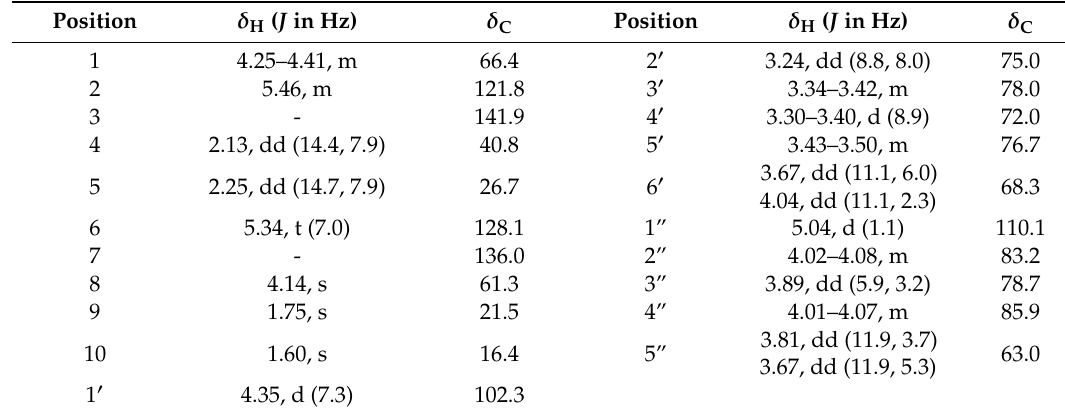
Table 2. 1 H- and 13 C-NMR spectral data of 2 a